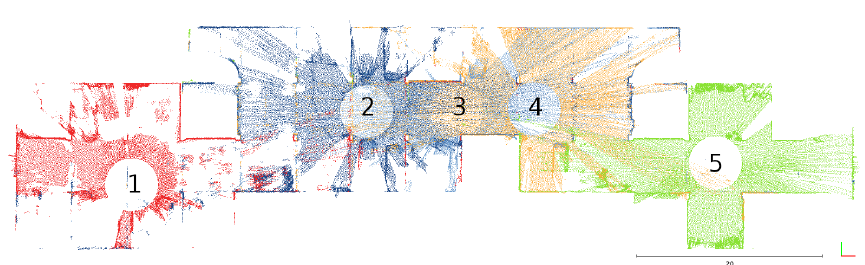
Figure 3. Measurement stations. Stations 2 and 3 were used in calibration. Stations 1, 4, and 5 were used in